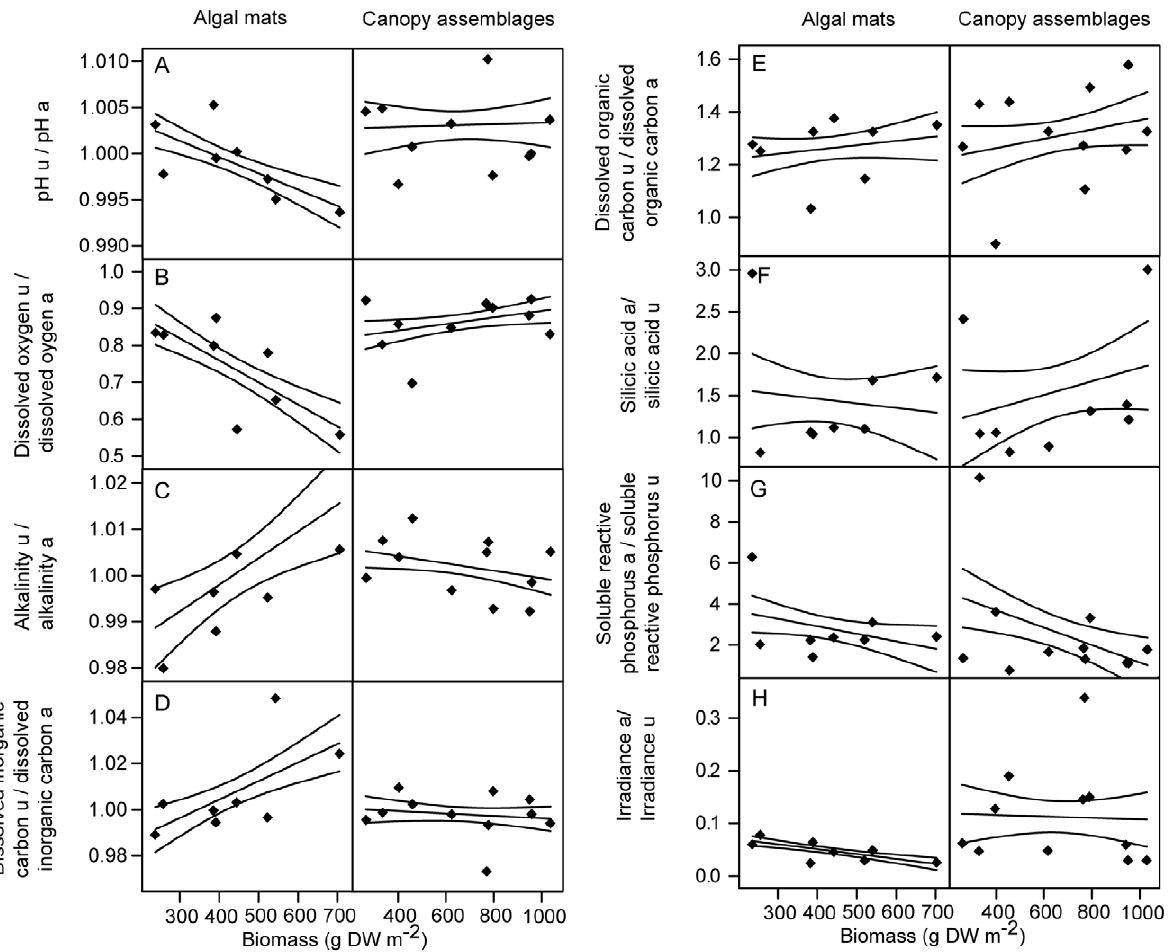
Figure 2. The effects of macroalgal biomass and assemblage type on the physical and chemical conditions underneath and above macroalgal assemblages in the field on inshore coral reefs. Ratio of (A) pH, (B) dissolved oxygen (DO, mg L 2 1 ), (C) alkalinity (ALK, m Eq/kg), (D) dissolved inorganic carbon (DIC, m M), (E) dissolved organic carbon (DOC, mg L 2 1 ), (F) silicic acid (Si, m M), (G) soluble reactive phosphorus (SRP, m M) and (H) irradiance ( m mol photons m 2 2 s 2 1 ) underneath (u) and above (a) macroalgal assemblages as a function of macroalgal biomass and assemblage type (mat-forming vs canopy-forming assemblages; see also Table 2). Lines are linear model fits and 95% confidence intervals.